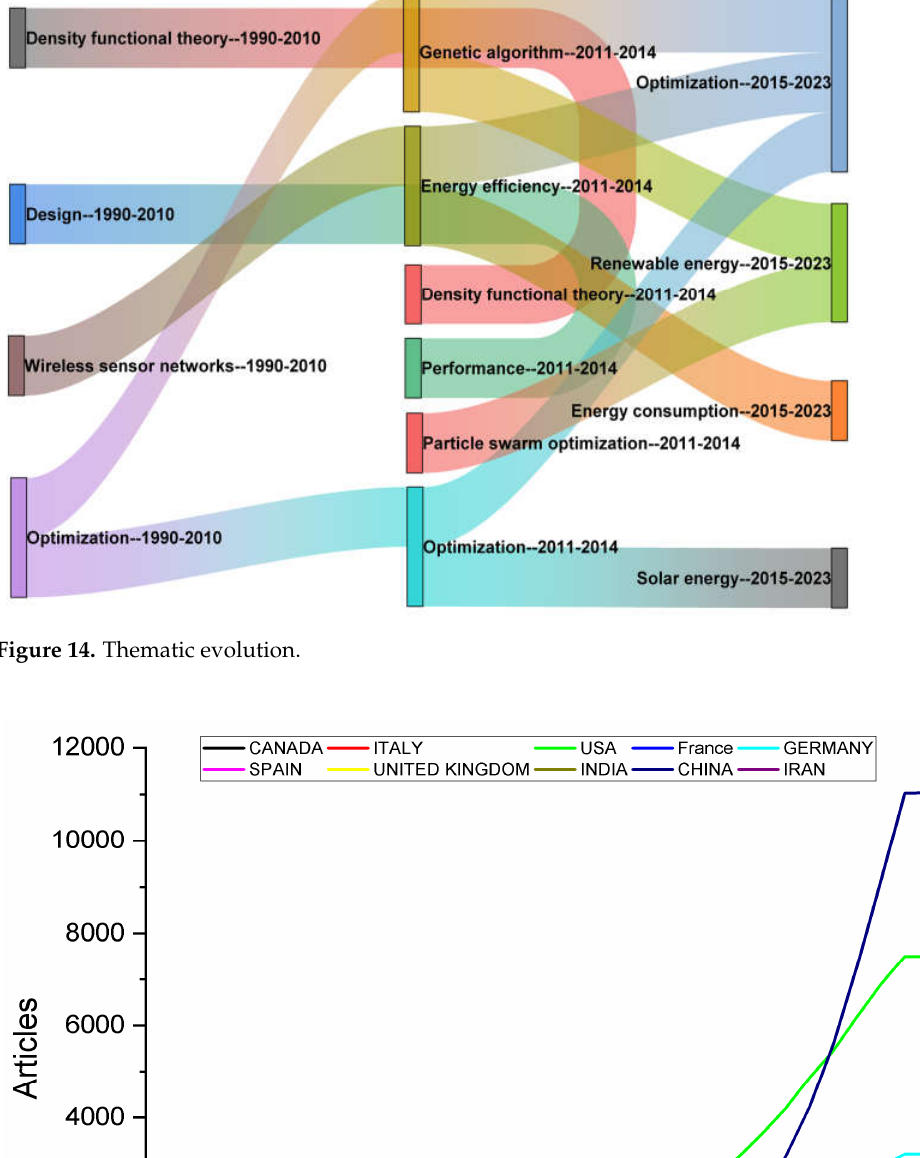
Figure 16. Number of articles over time according to country of origin. Noting that an issue, in order to be credited to a nation’s scientific production, needs at least one of the authors to be affiliated with an educational and/or research institution of that country, tells us that it is conceivable that the same scientific article is accounted